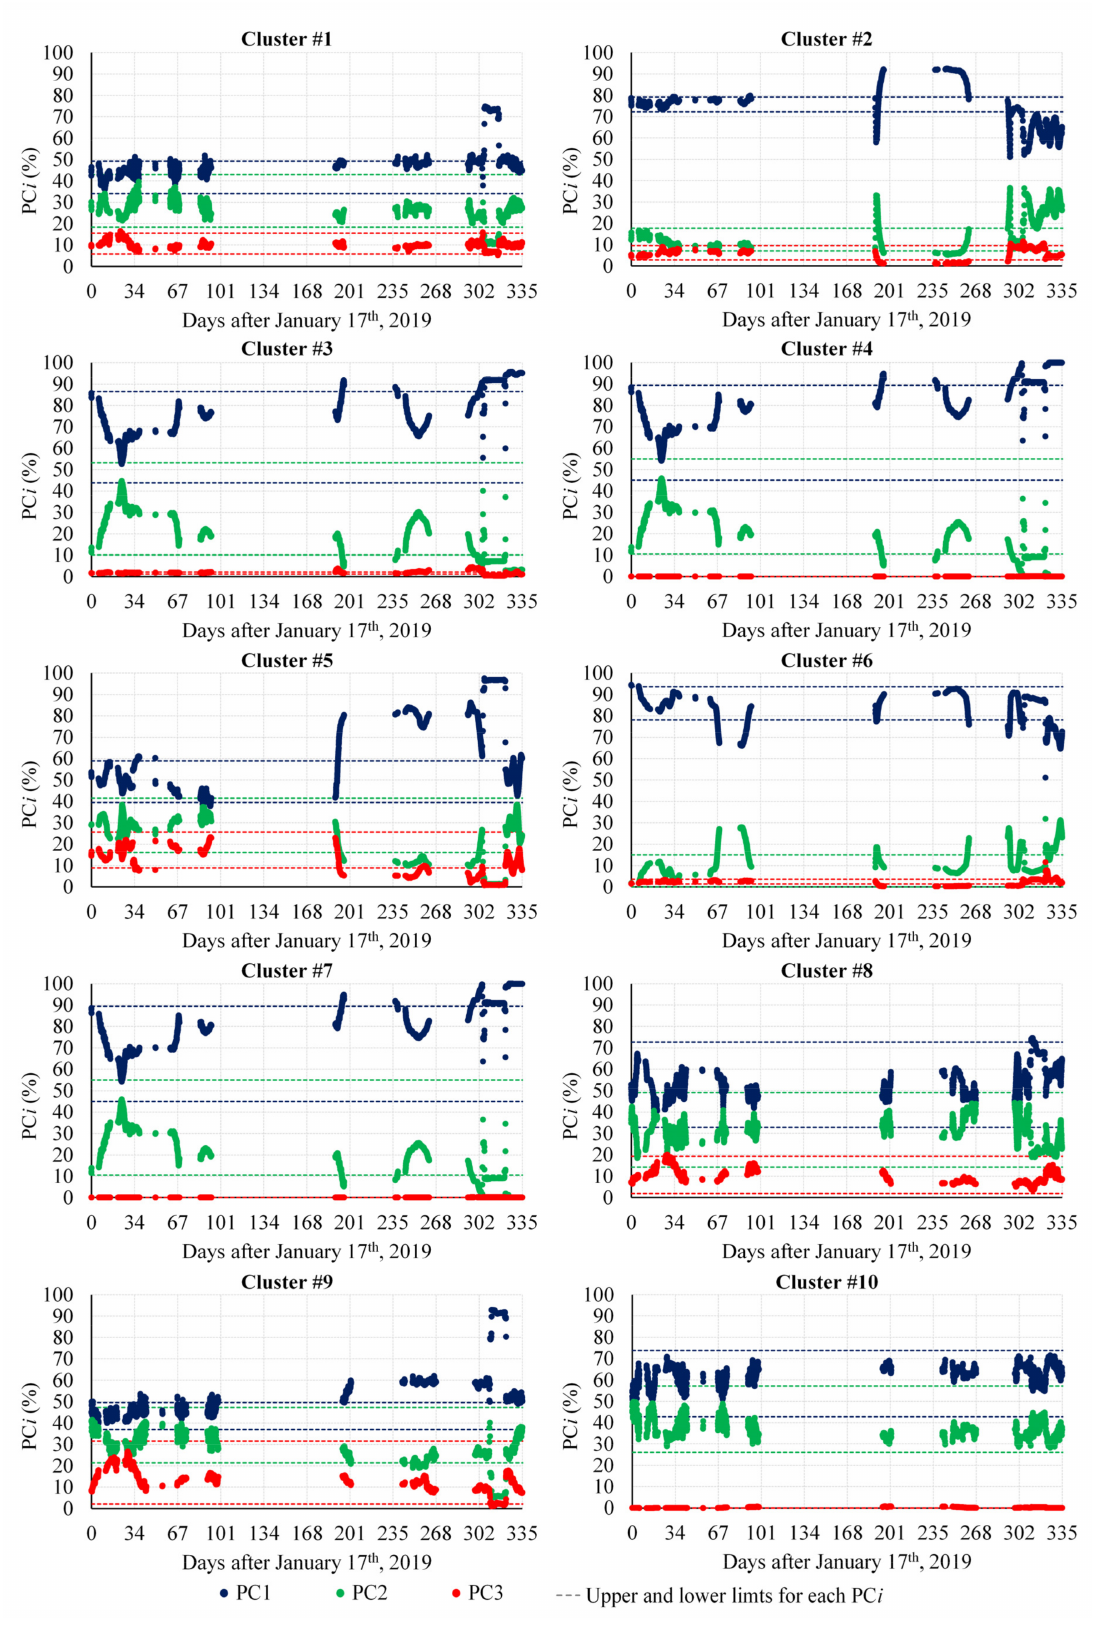
Figure 6. Cluster analysis results over time. Each graph presents the values of the percentage weight of each main component in relation to the total variability of the cluster analyzed between 17 January 2019 and 19 December